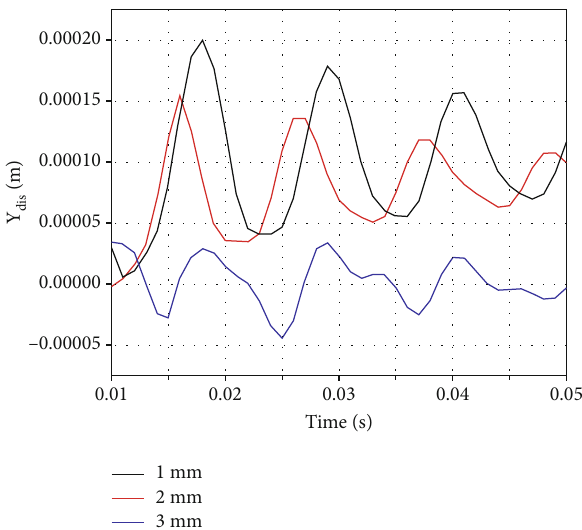
Figure 4: The right side displacement of vocal folds in Y direction of sulcus vocalis(1mm, 2 mm, and